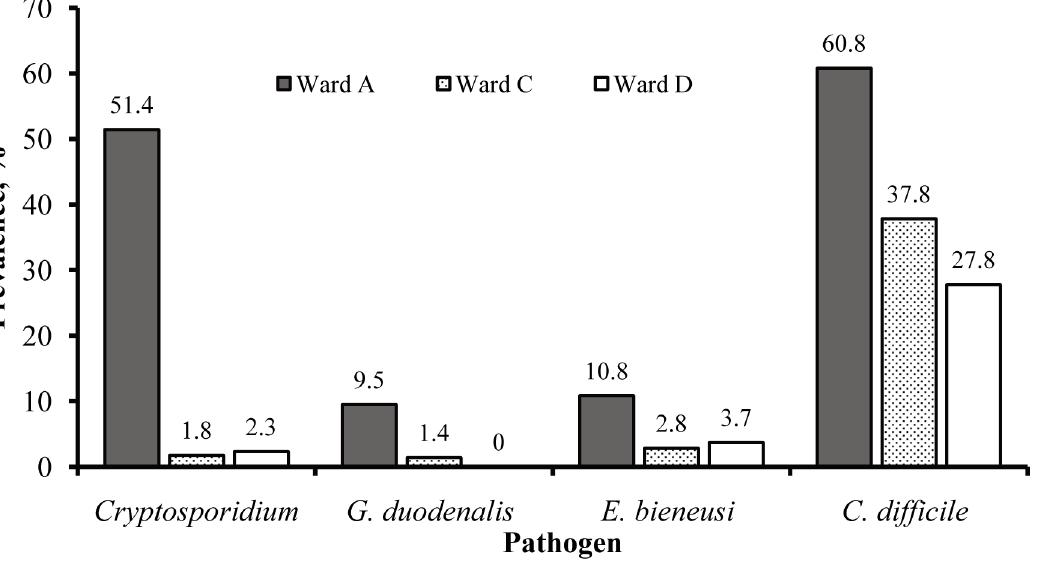
Figure 1. Infection rates of study pathogens in case and control wards. There were 74 children in case ward (Ward A), 283 and 216 children in control wards (Wards C and D).